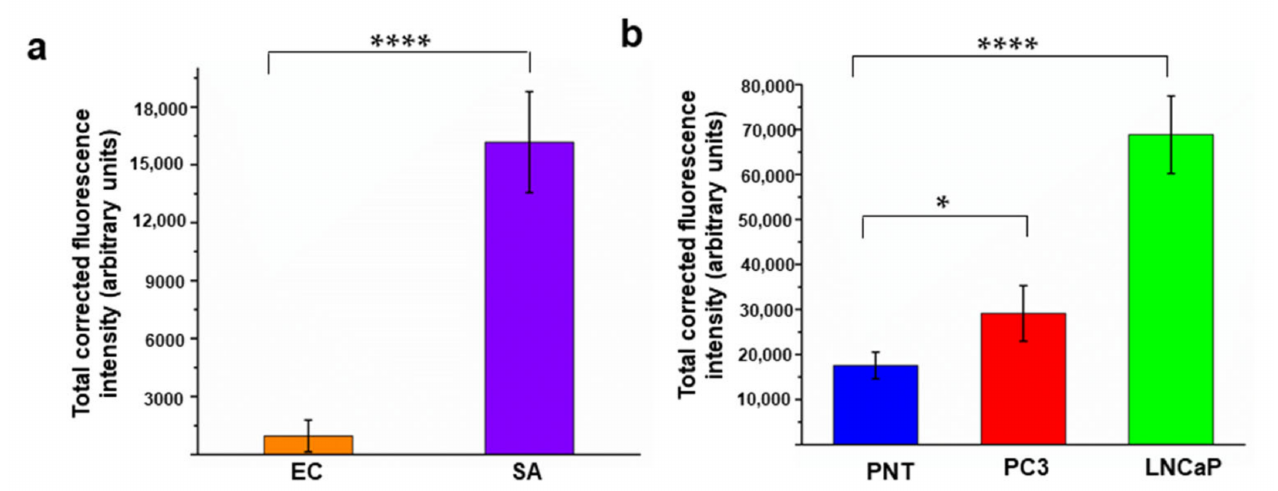
Figure 5. Total corrected fluorescence intensity of AgInSe/ZnS QDs in ( a ) Gram-negative Escherichia coli (EC) and Gram- positive Staphylococcus aureus (SA); ( b ) prostate cells PNT, PC3, and LNCaP. Statistical significance was assessed by one-way ANOVA with Dunnett’s multiple comparison test for * p < 0.1 and **** p <